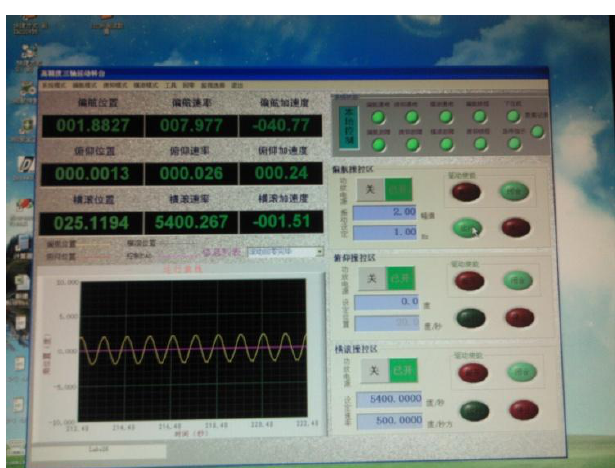
Figure 9. Test control